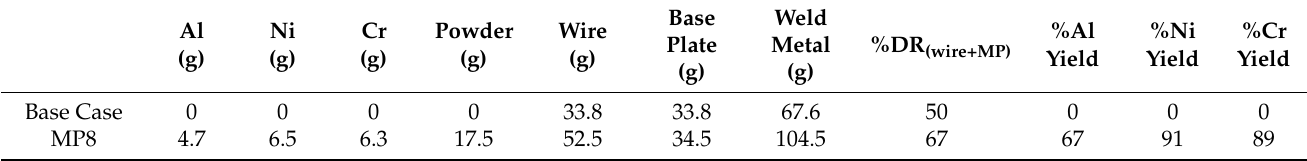
Table 5. Mass balance numbers and percentage yield calculation results for Al, Ni, and Cr.